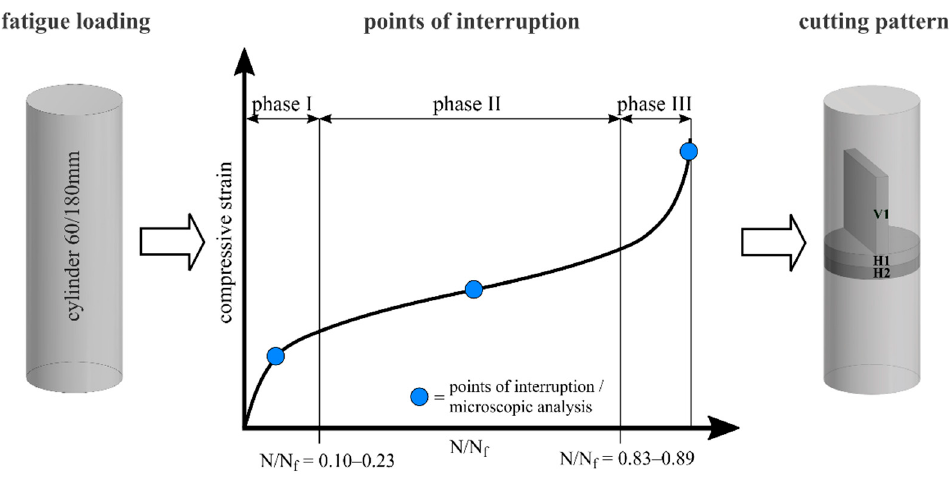
Figure 2. Points of interruption of partial tests and cutting pattern (schematic presentation).